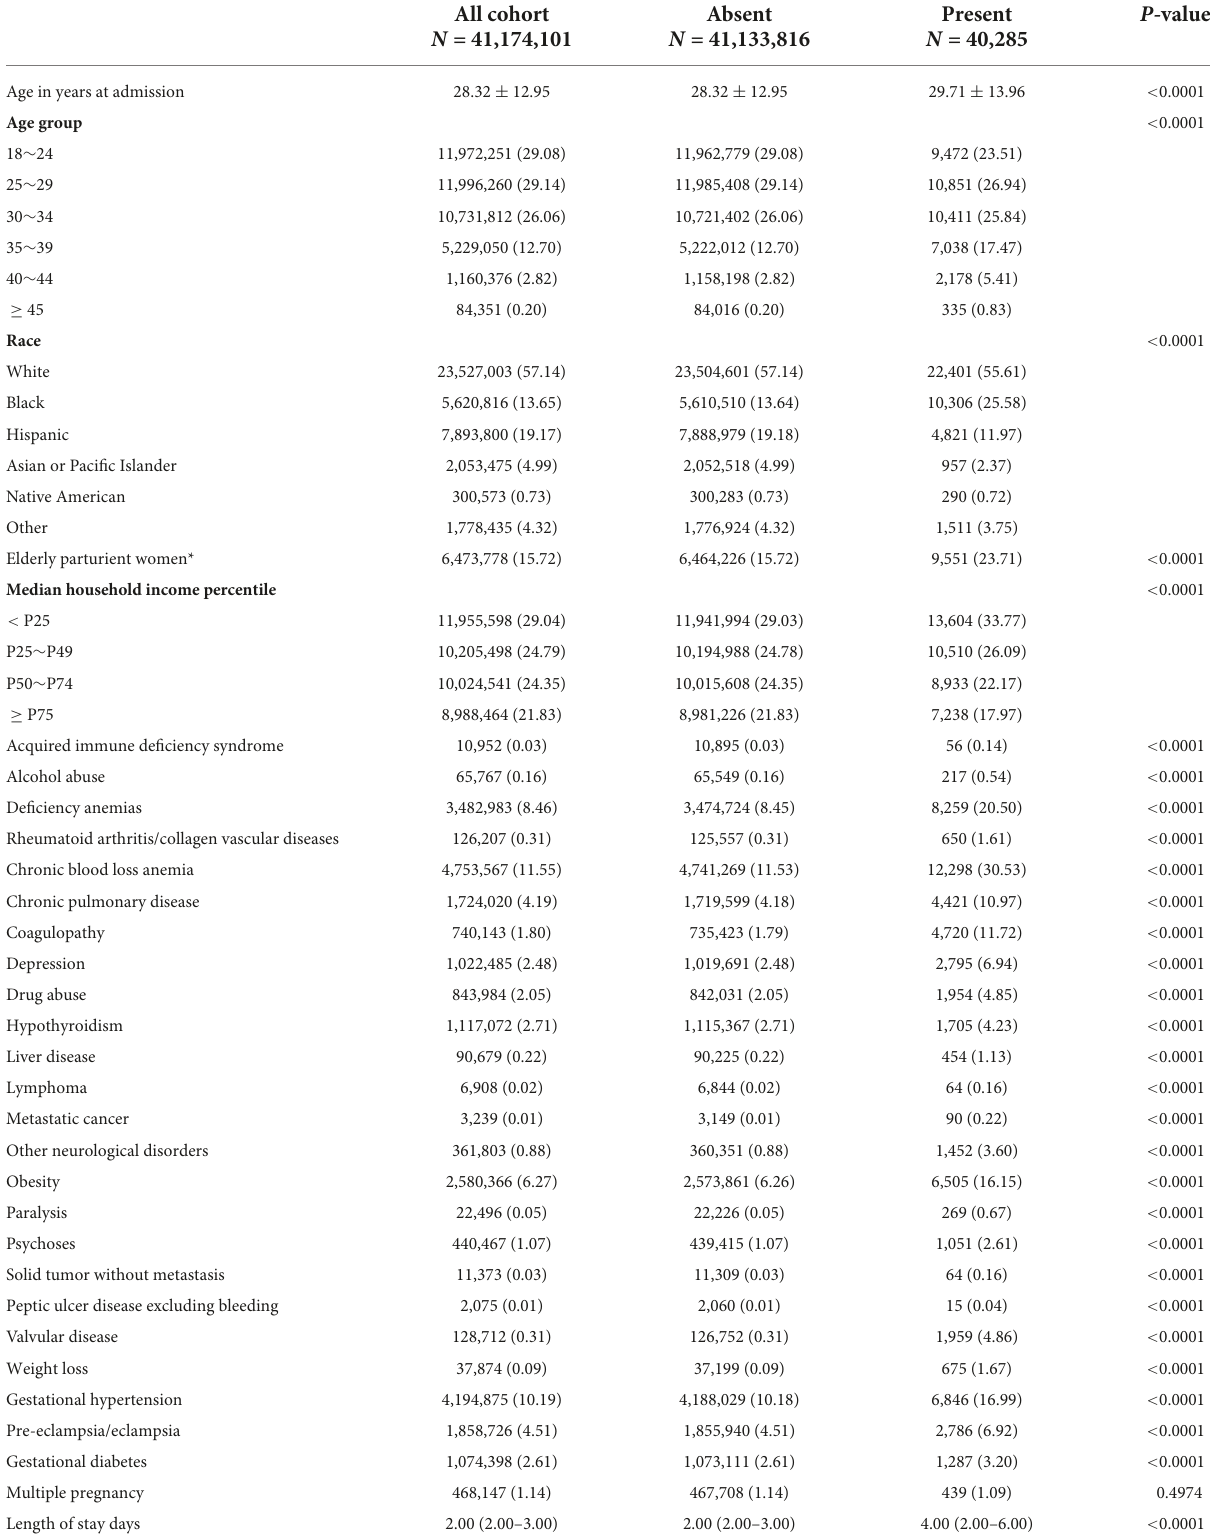
TABLE 1 Characteristics and outcomes in acute high-risk chest pain diseases during pregnancy and